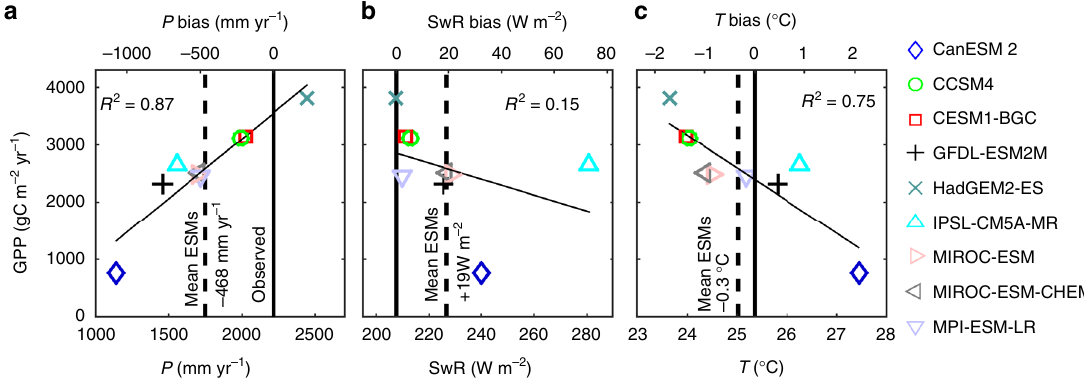
Fig. 1 Earth system model climate drivers and gross primary productivity averaged over the Amazon basin for 1981 – 2005. a Mean Amazon basin Earth system model (ESM) gross primary productivity (GPP) dependency on ESM mean annual precipitation. Black represents observation-based reference Amazon basin mean annual precipitation 56, 57 ( P ), with ESM biases on upper X -axis. b ESM GPP dependency on ESM mean annual downward shortwave radiation (SwR) and bias relative to shortwave radiation from CRUNCEP 58 . c ESM GPP dependency on ESM mean annual temperature ( T ) and bias relative to temperature from CRUNCEP. In a multiple regression, the three climatic drivers together explain 93% ( R 2 = 0.93) of the differences in simulated